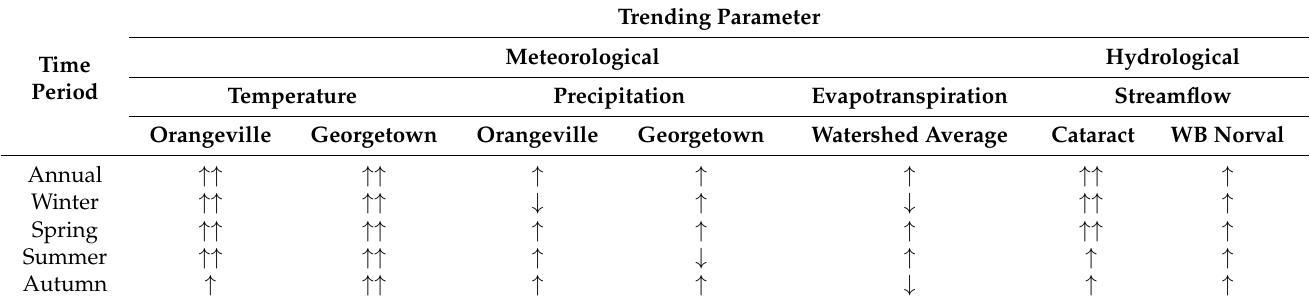
Table 7. Summary of the trend analysis for the urban and rural stations for the period